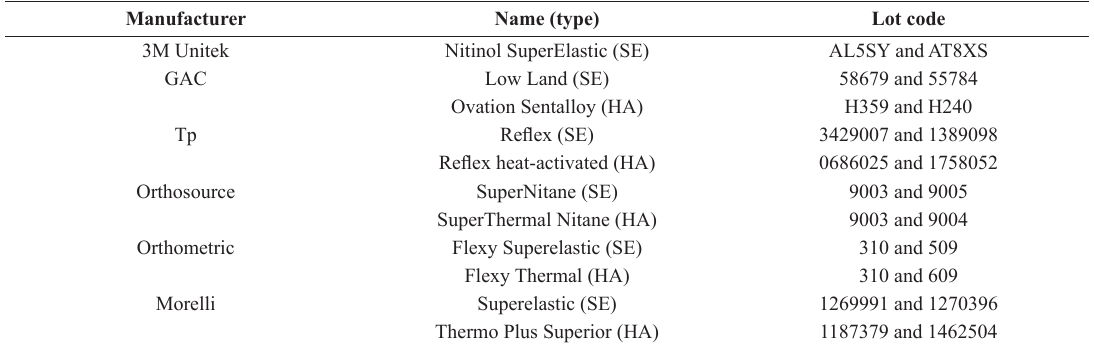
Table 1. Description of NiTi wires used in this work.